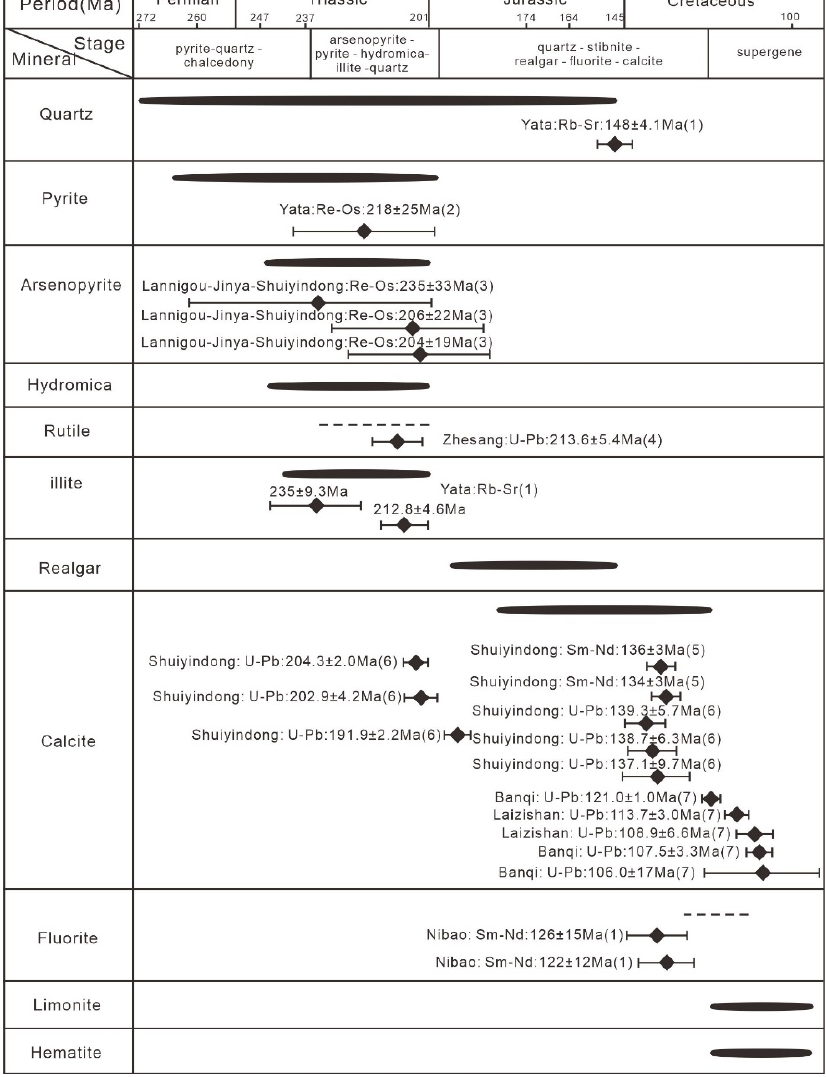
Figure 11. Compiled chronology and mineral formation sequence in the Nanpanjiang-Youjiang Basin [24,32,37,50–52,56].